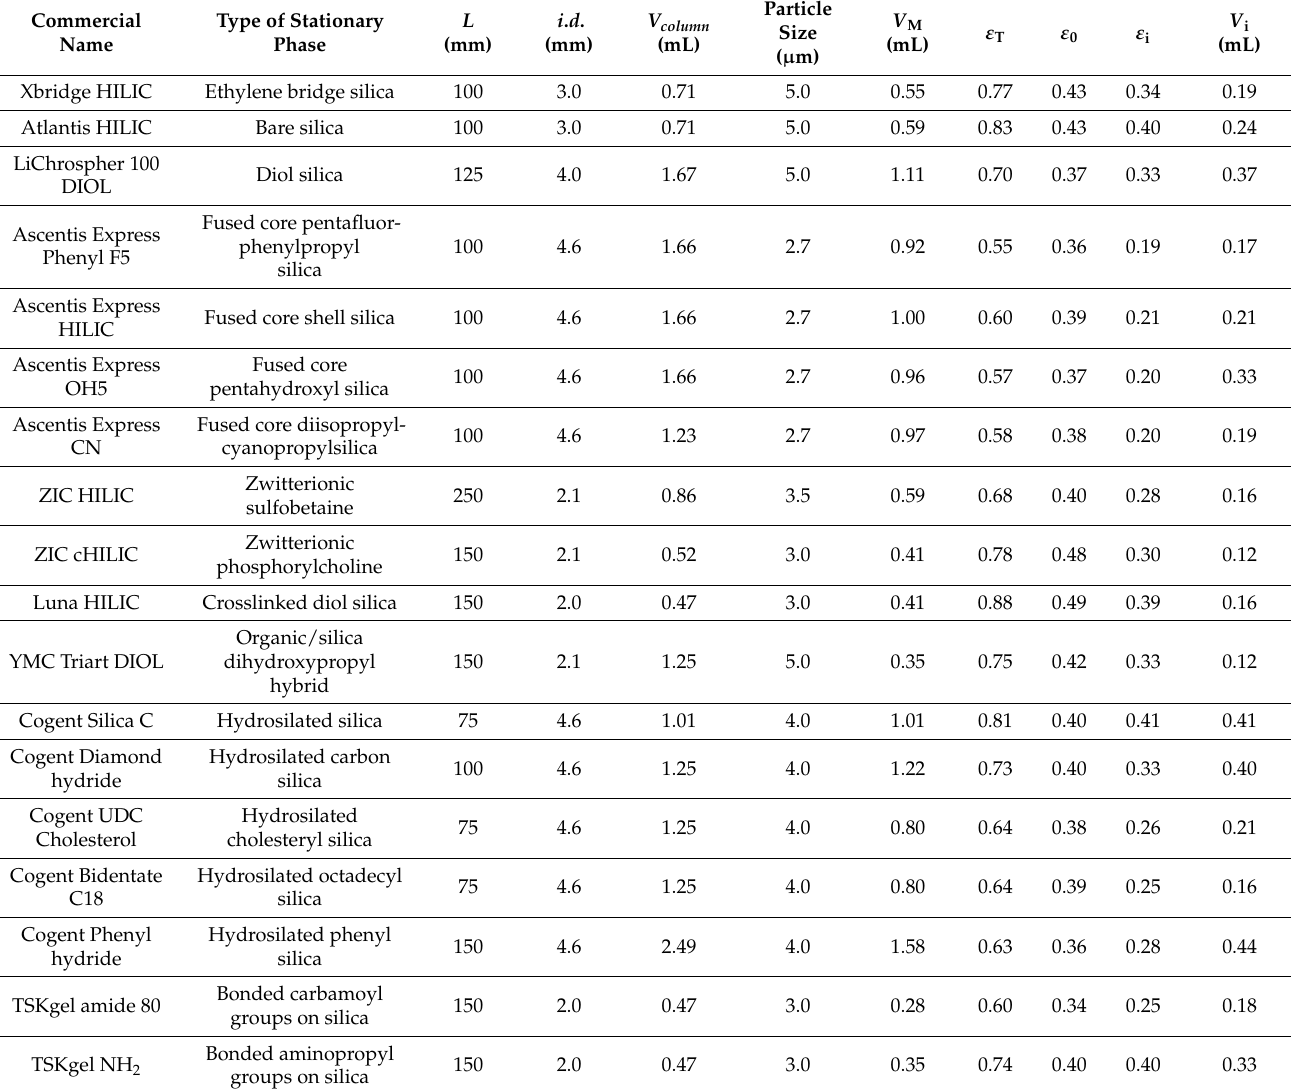
Table 1. Types and dimensions of the columns